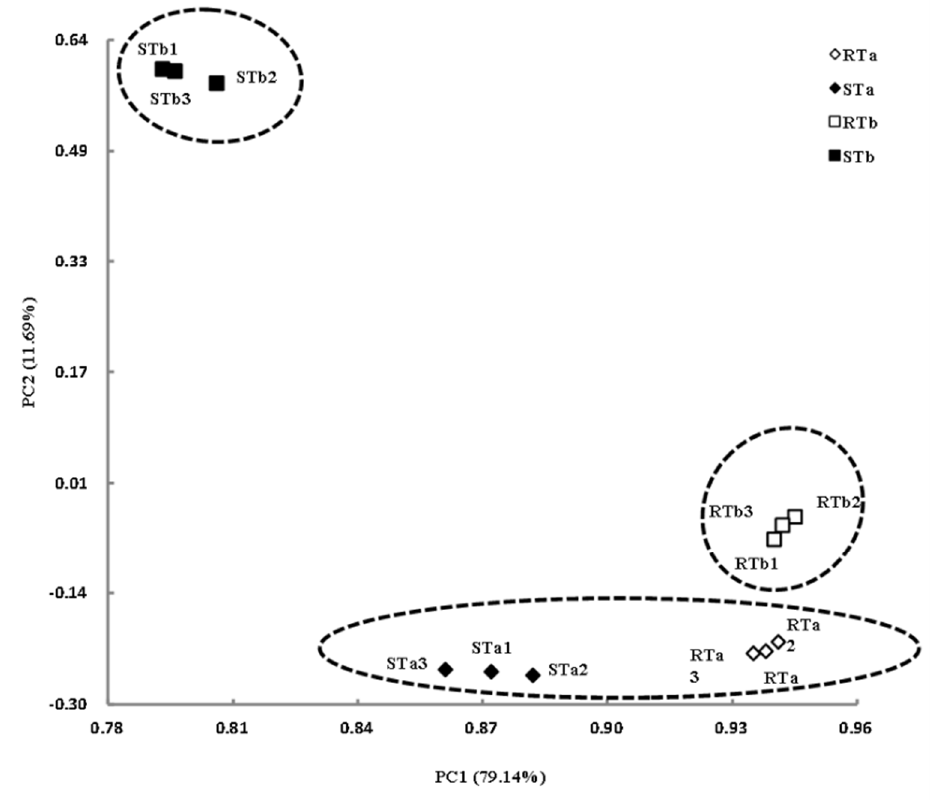
Figure 6. Comparison of bacterial communities in different treatments through Principal Component Analysis (PCA).